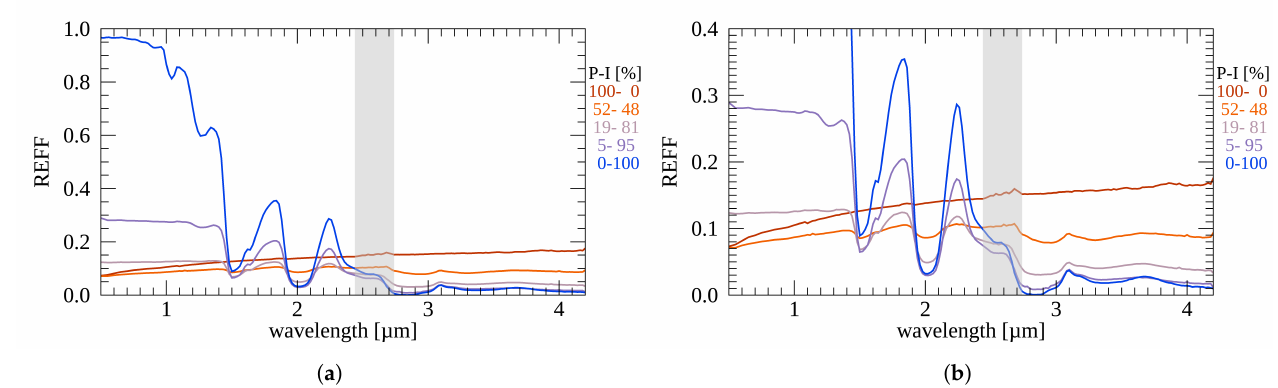
Figure 6. ( a ) Water ice–pyrrhotite 25–50 intimate mixture spectra. Mass fractions are indicated (P: pyrrhotite, I: water ice). ( b ) Zoom at low reflectances. The light gray bands indicate a spectral region where possible residual water vapour contamination in the optical path may affect the resulting spectra.